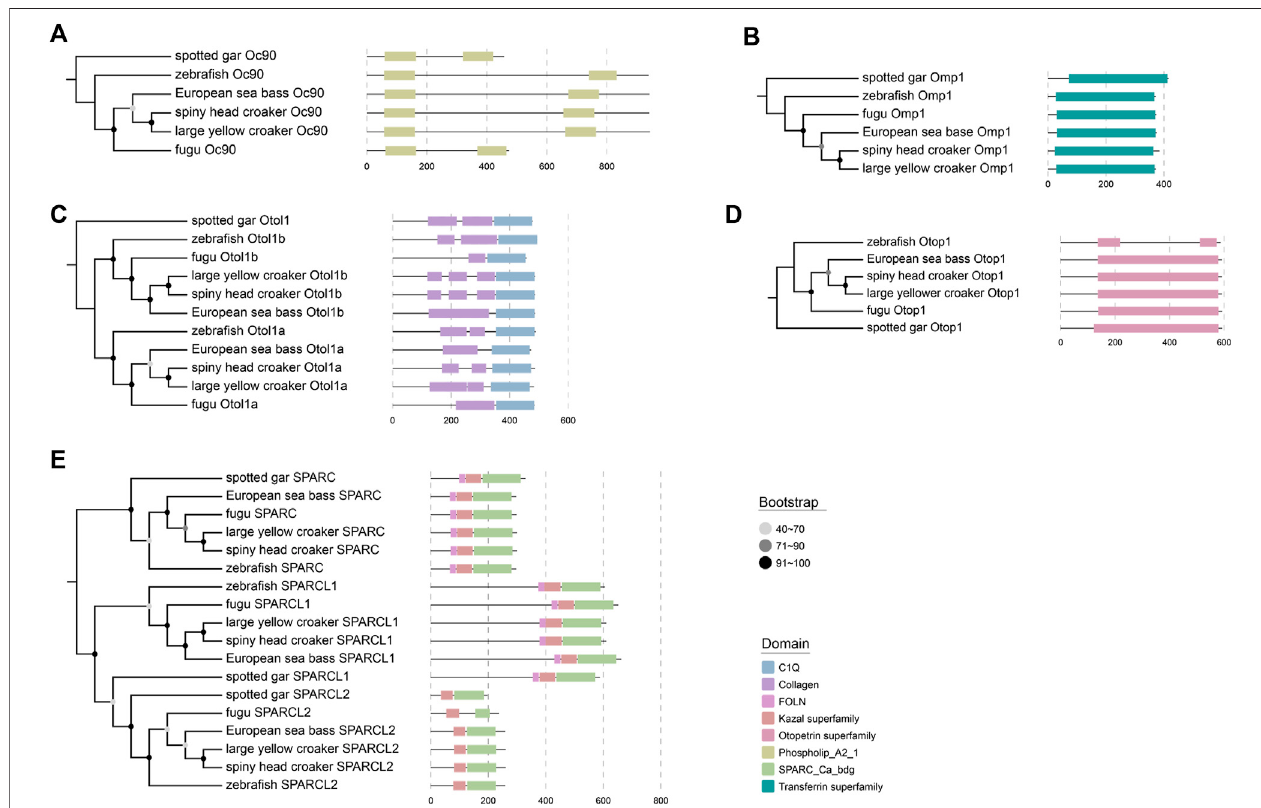
FIGURE 4 | Phylogeny of otolith-related genes among six examined fi sh species. The detailed phylogenetic topology of Otoconin-90 [Oc90; (A) ], Otolith matrix protein 1 [Omp-1; (B) ], Otolin-1a (Otol1a) and Otolin-1b [Otol1b; (C) ], Otopetrin-1 [Otop1; (D) ], secreted protein acidic and rich in cysteine (SPARC), SPARC Like 1 (SPARCL1), and SPARC Like 2 [SPARCL2; (E) ] was constructed individually.